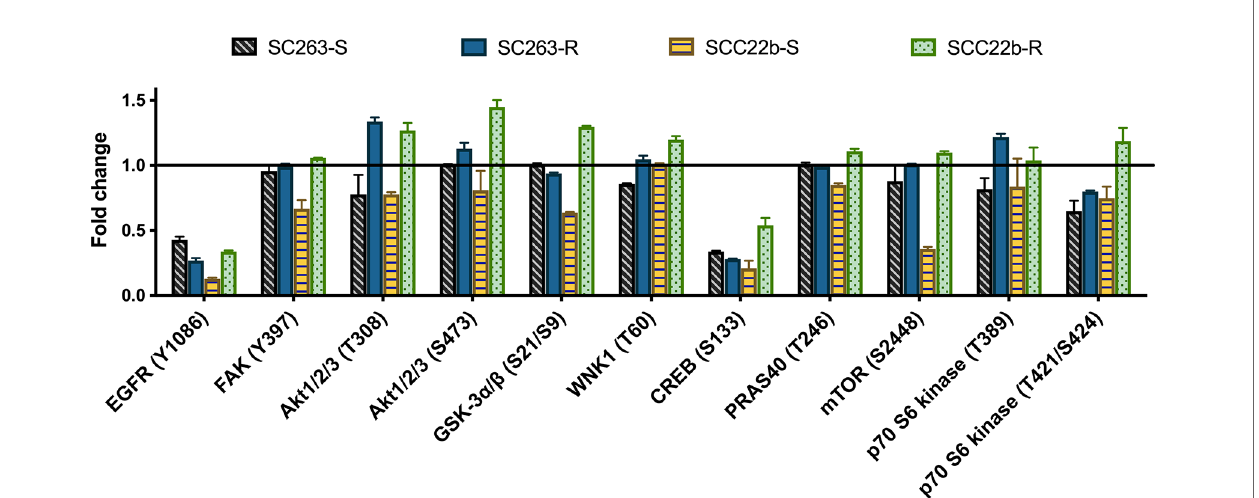
FIGURE 1 | Quanti fi cation of the human phospho-kinase array blots of cetuximab sensitive (SC263-S andSCC22b-S) HNSCC cell lines and corresponding acquired cetuximab resistant (SC263-R and SCC22b-R) variants. Graph represents the fold change ofselected substrates, i.e. phosphorylatedEGFR, Akt1/2/3and other substrates involved inthe Aktpathway, after cetuximab treatment. Protein phosphorylation pro fi lingwas conducted with one cell lysate. The fold changes were calculated bythe ratio of the mean integrated opticaldensity (duplicates)in treatment versus control groups. Error barswere calculated based ondifferences between duplicates. Suf fi x -S: cetuximab sensitive cellline and suf fi x -R:acquired cetuximabresistant